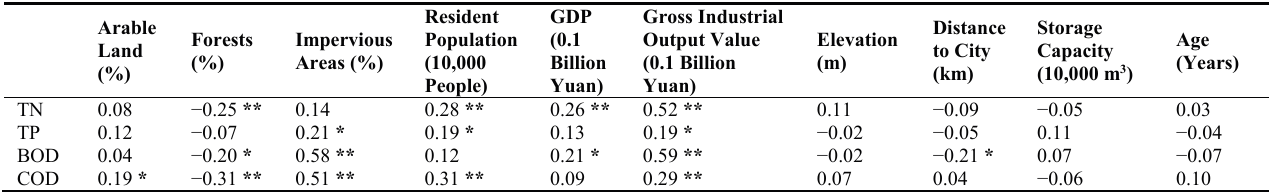
Table 2. Correlation analysis between independent variables and water quality